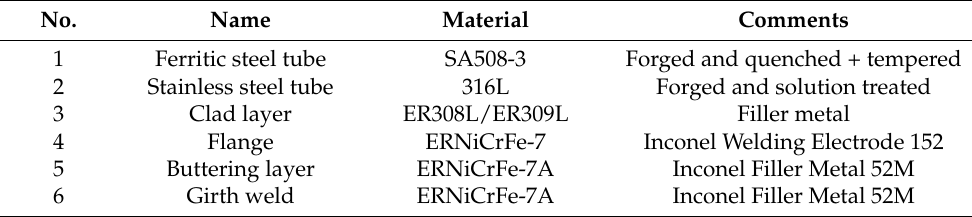
Table 1. Materials used for the various parts of the mock-up.